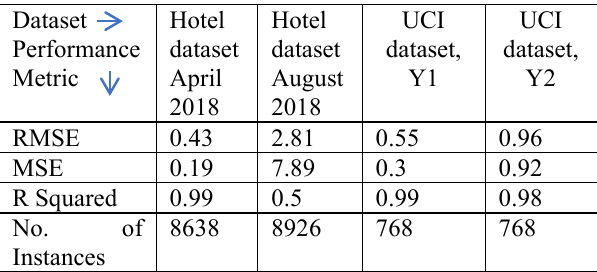
Table 4. Comparative Results of both datasets Dataset